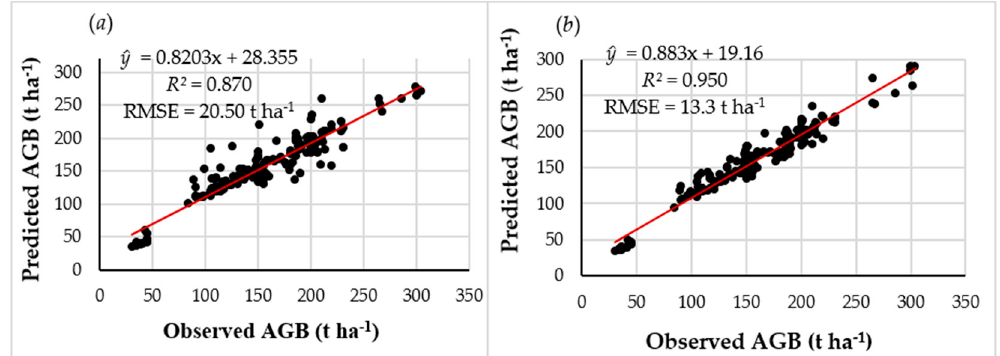
Figure 3. Observed vs predicted aboveground biomass (t ha − 1 ) using the RF algorithm and ( a ) pooled data and ( b ) only selected important variables.